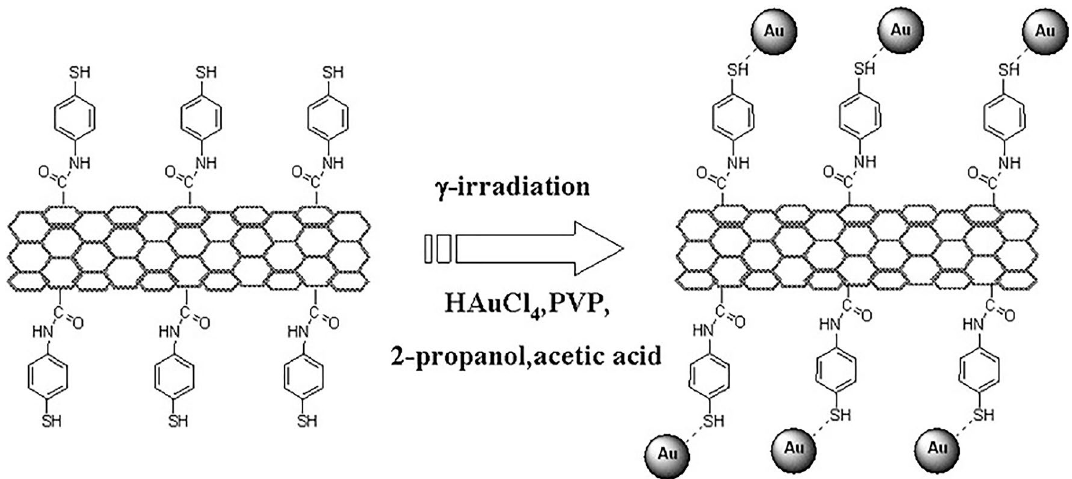
Fig. 6 Preparation procedure for Au@MWNT catalyst by γ-irradiation for fuel